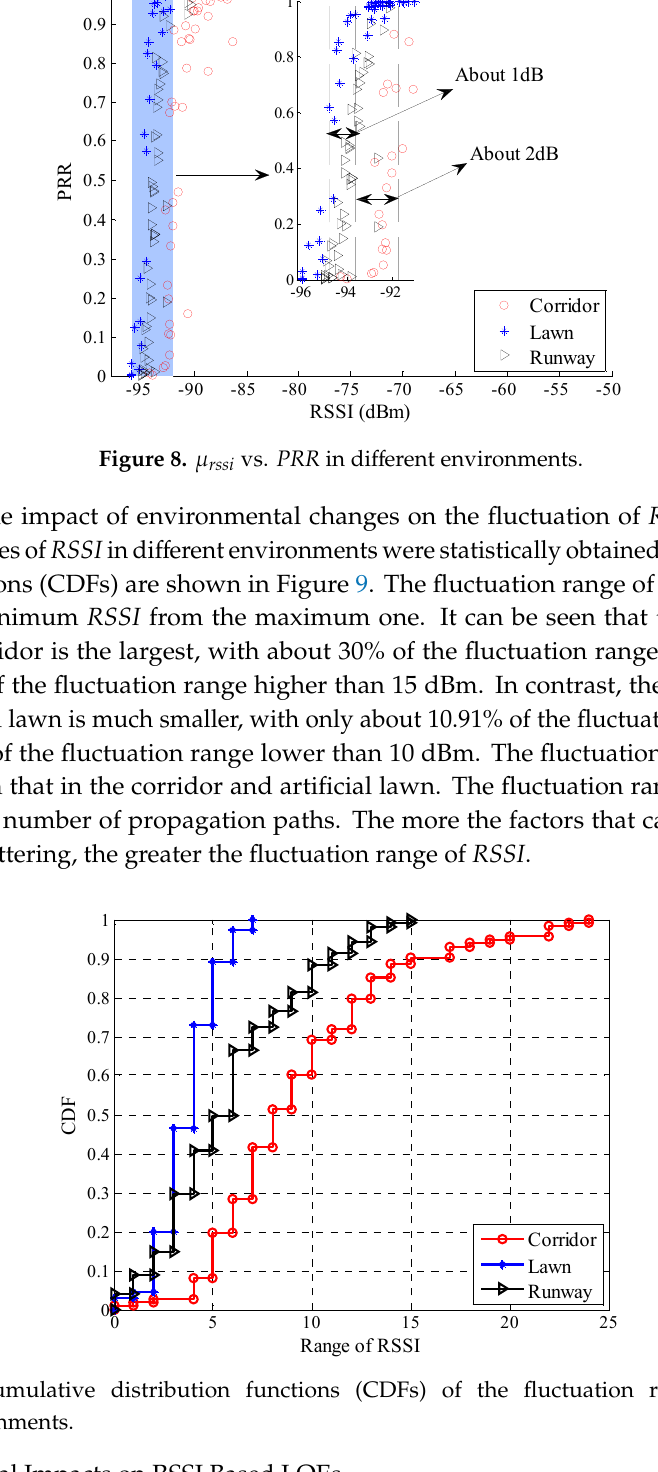
Figure 7. Received Signal Strength Indicator ( RSSI ) vs. PRR in different environments.